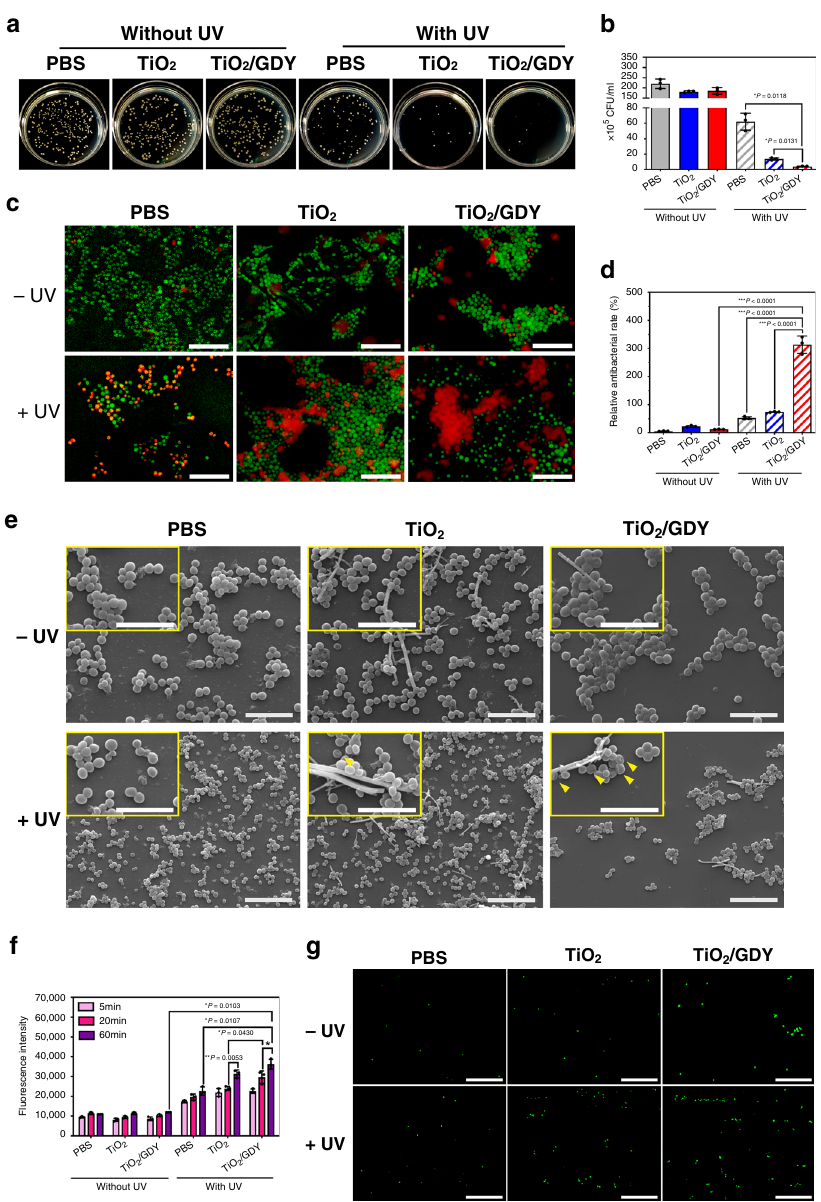
Fig. 3 Photocatalytic antibacterial effects of TiO 2 /GDY and TiO 2 in vitro. MRSA were treated with TiO 2 , TiO 2 /GDY or PBS, with or without UV (365 nm, 2 W cm − 1 ) irradiation. a , b Photos of agar plates and quantitative analysis of bacterial colonies. c Live/dead stained images of MRSA bio fi lms with photocatalytic treatment (scale bar = 10 μ m). d Semiquanti fi cation of the live/dead staining for the ratio of PI- and calcein AM-stained areas. e SEM images of MRSA bio fi lms after exposure to photocatalytic treatment with nano fi bers; yellow arrowheads in the magni fi ed inset images indicate holes on the bacterial surface; scale bar = 5 μ m (upper), 10 μ m (below). f Quantitative analysis of radical oxygen species (ROS) in MRSA 5, 20, and 60 min after photocatalytic treatment. g Fluorescence images of ROS in bacteria for 24 h (FITC-tagged probes); scale bar = 100 μ m. The data of b , d and f are shown as the mean ± S. D., error bars = Standard Deviation ( n = 3 independent experiments, one-way ANOVA was applied in b , d , and multiple t test was applied in f for statistical analysis, * p < 0.05; ** p < 0.01; *** p < 0.001). Source data of b , d , f are provided as a Source Data fi